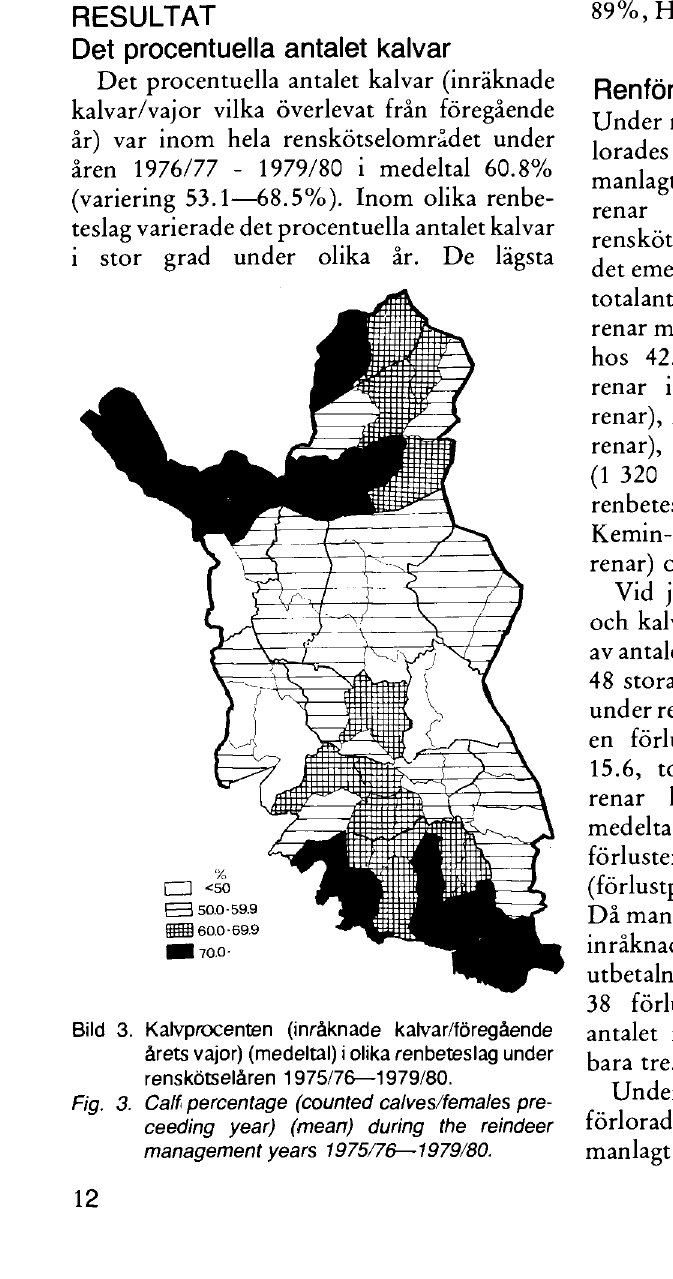
ceeding year) (mean) during the reindeer management years